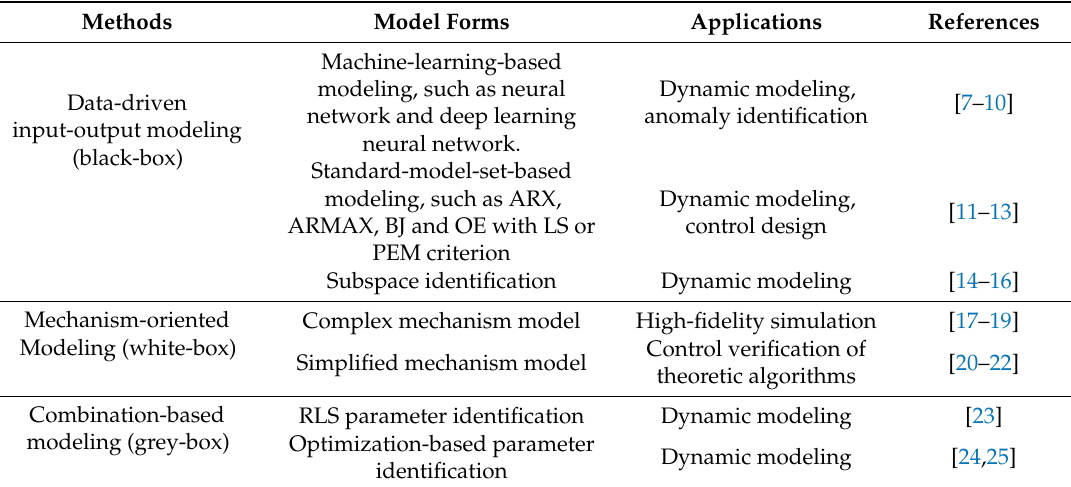
Table 1. Summary of di ff erent identification